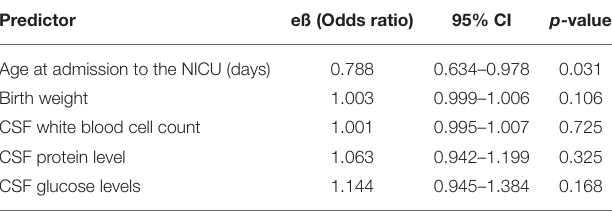
TABLE 4 | Neurodevelopmental outcomes of 30 neonates at 12 months of age. Neurodevelopmental assessment